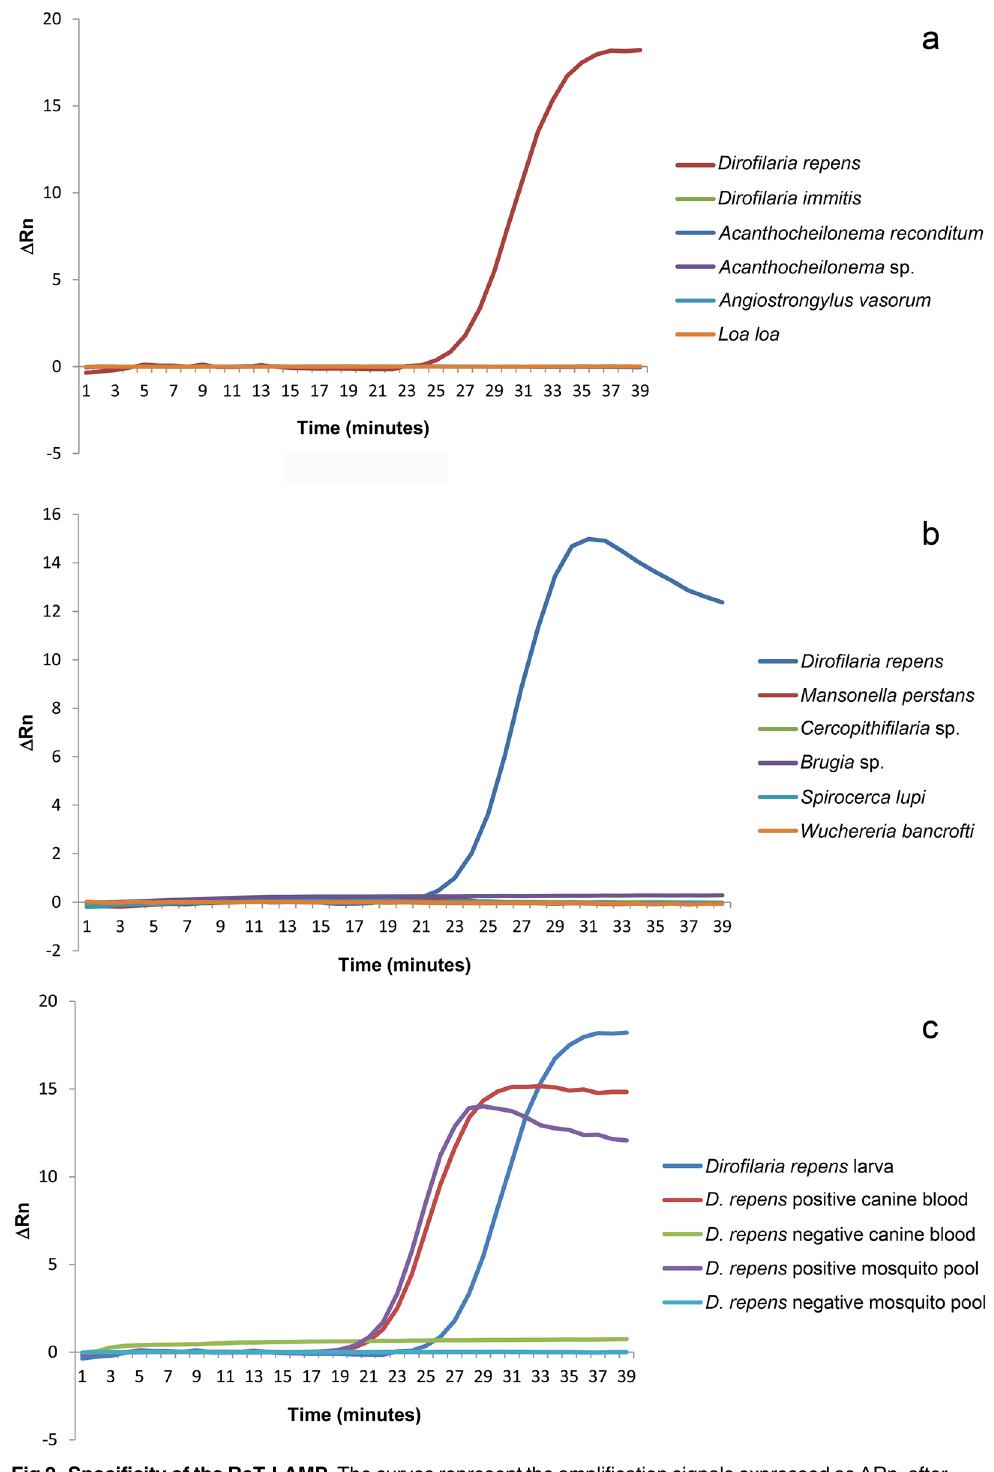
Fig 2. Specificity of the ReT-LAMP. The curves represent the amplification signals expressed as Δ Rn, after subtraction of the ROX reference dye fluorescence. a) and b) Amplification curves from ReT-LAMP carried out with DNA from larvae of previously identified species. The curves from species different from D . repens are overlapped because of the lack of an appreciable signal. c) Amplification curves from DNA extracted from biological samples (mosquitoes and canine